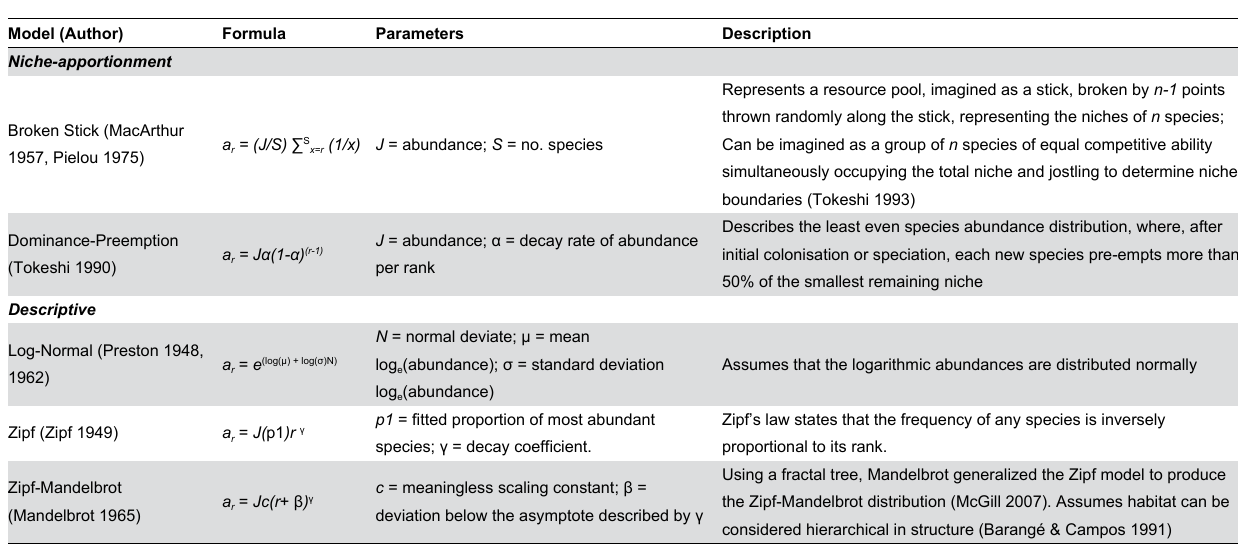
Table 1. Rank abundance models tested, their authors and